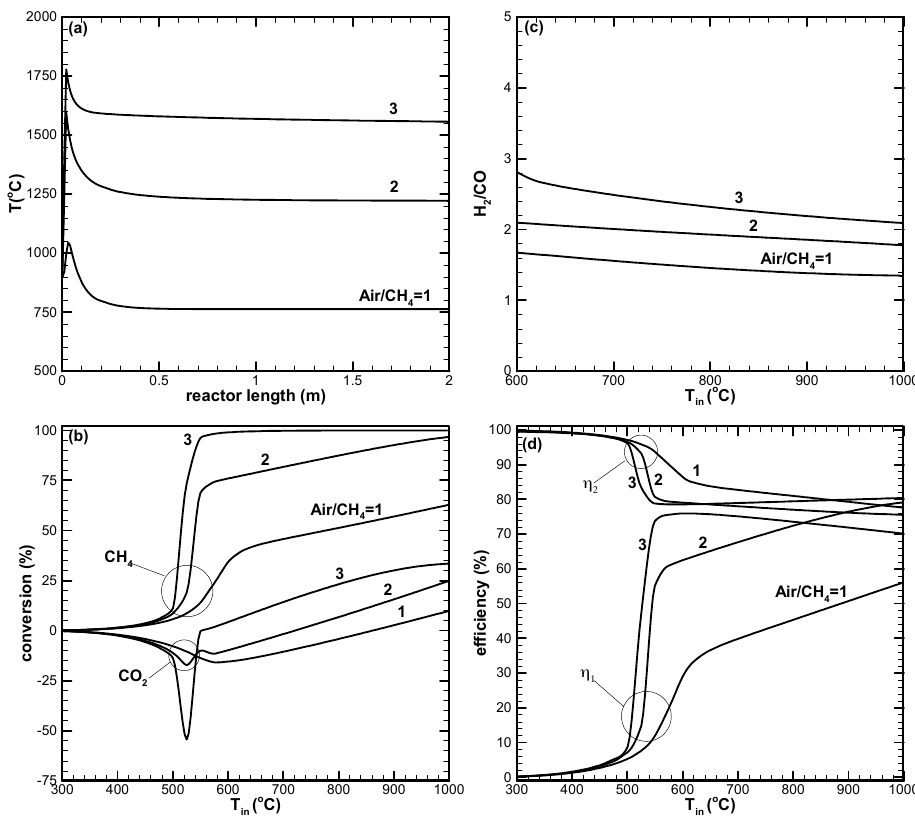
Figure 7. Air/CH 4 ratio effect on the TR process. The Air/CH 4 ratio is varied from 1 to 3 while the other parameters are kept unchanged, as listed in Table 1. ( a ) Temperature variation along the reactor with T in = 900 °C; ( b ) CH 4 and CO 2 conversions; ( c ) H 2 /CO ratio; and ( d ) first- and second-law efficiencies.